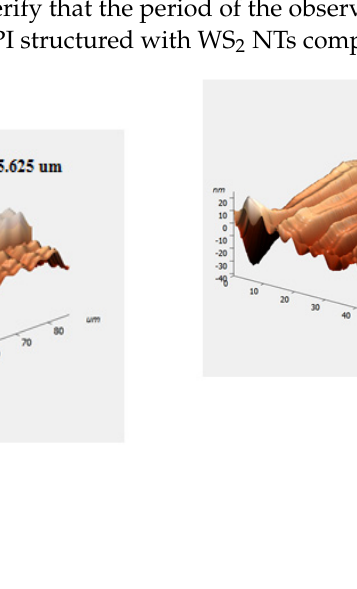
Figure 4. The relief obtained on the pure polyimide surfaces ( a ); the relief obtained at the WS 2 NPs-doped polyimide surface ( b ). The dimensions are equal for both images.